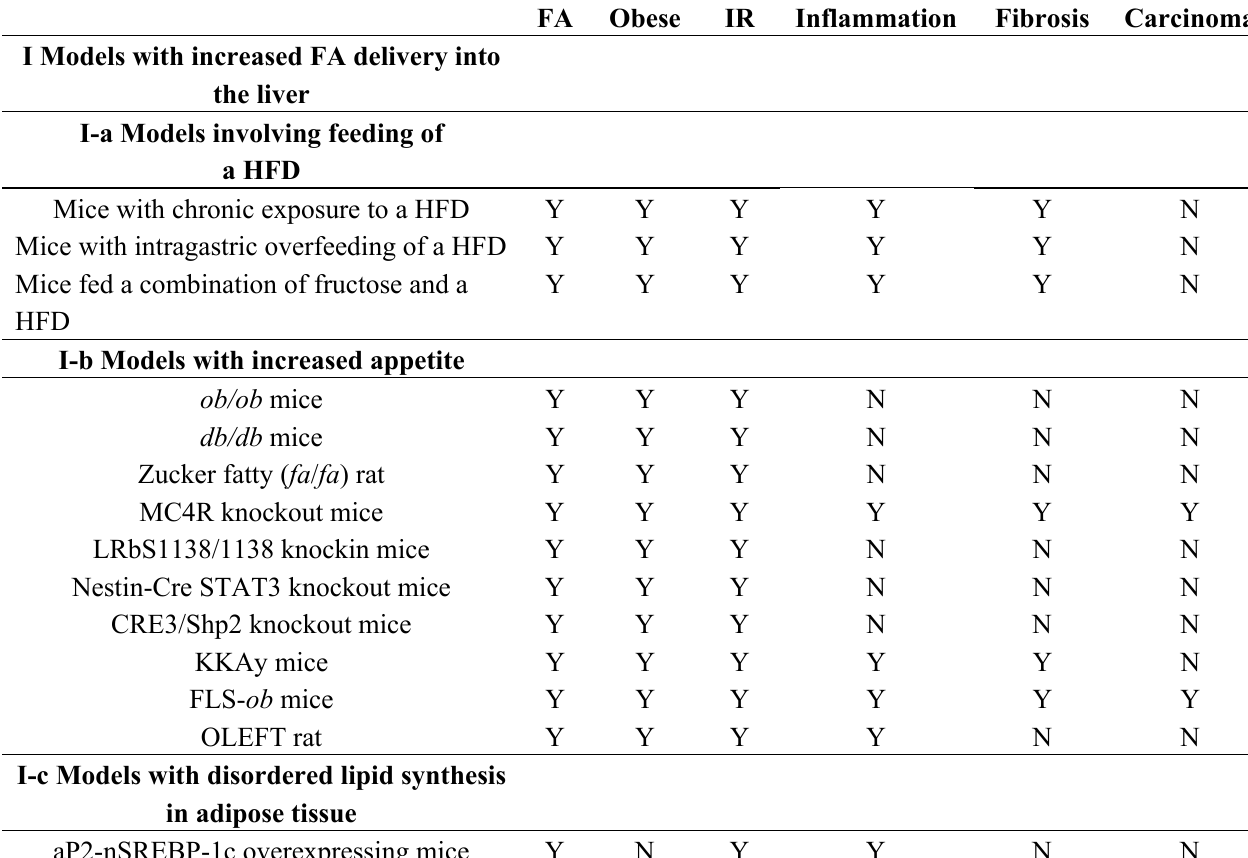
Table 1. Current rodent models of nonalcoholic fatty liver disease/nonalcoholic steatohepatitis. FA Obese IR Inflammation Fibrosis Carcinoma I Models with increased FA delivery